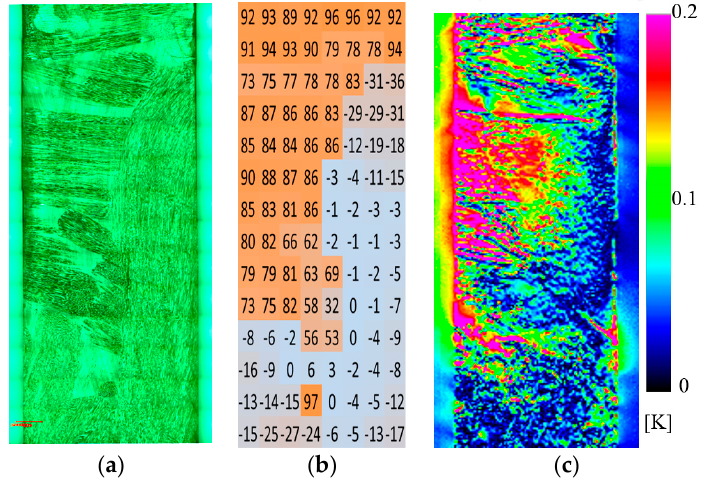
Figure 4. Fiber orientation angles and thermoelastic temperature change ( σ max = 100 MPa, f = 7 Hz): ( a ) optical image; ( b ) orientation angle; ( c ) thermoelastic temperature change.